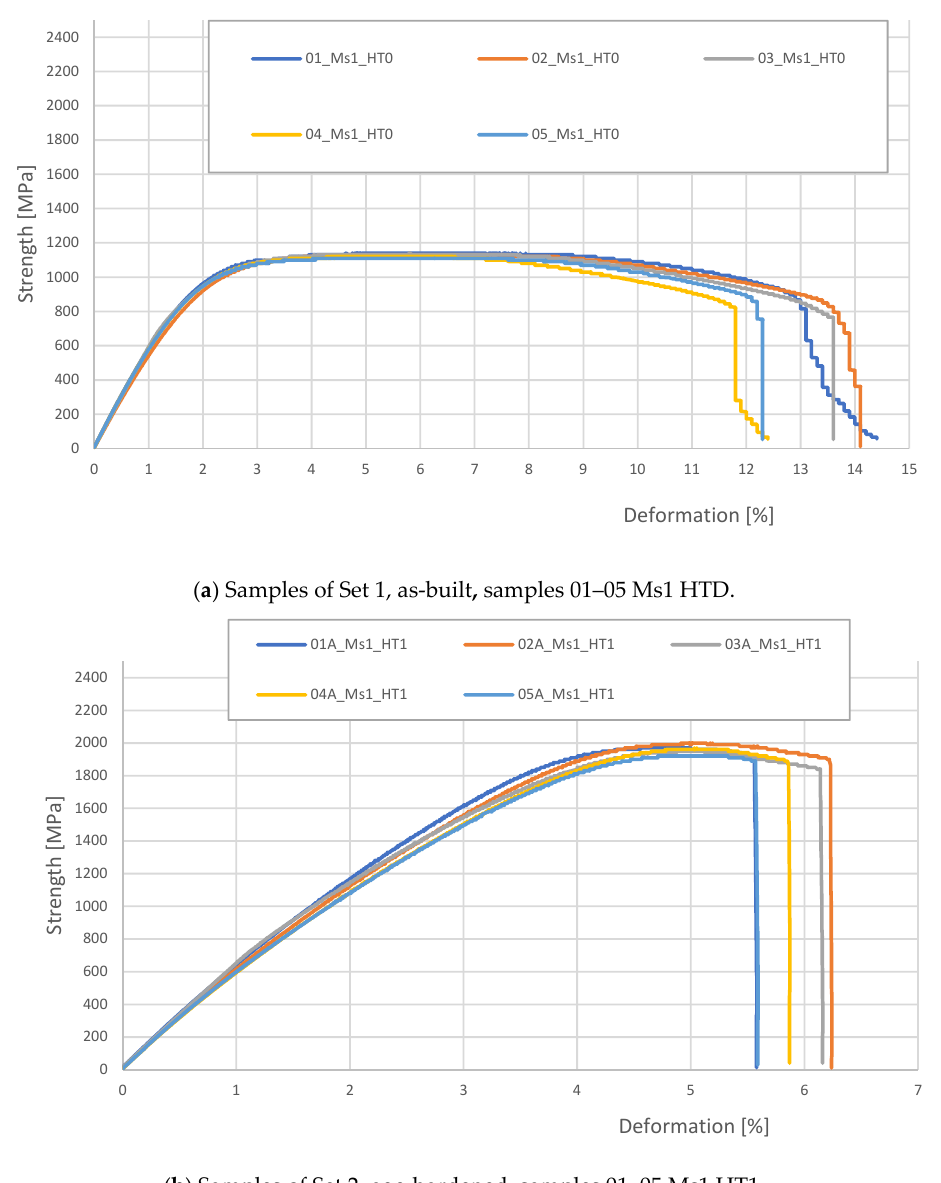
Figure 3. Strength tests report.